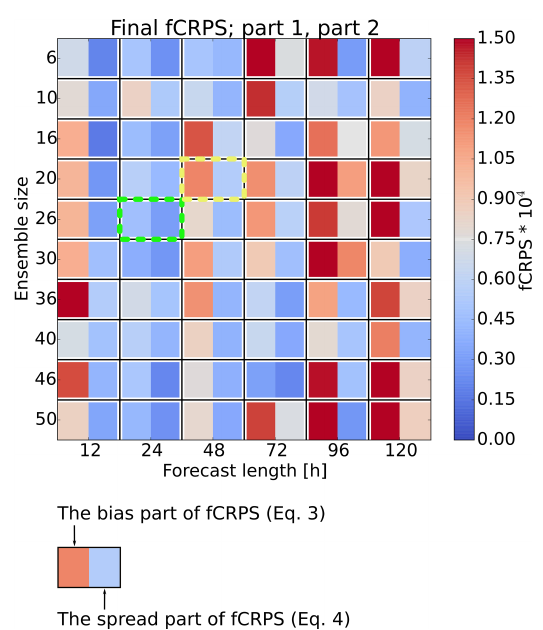
Figure 3. Components of fCRPS from the final iteration of the con- vergence tests with various forecast ranges and ensemble sizes. In this example, the optimisation algorithm is EPPES and the param- eter is θ 2 . The left-hand side of each block represents the average distance of the parameter values from the default value (Eq. 3), and the right-hand side represents the spread of the parameter value dis- tribution (Eq. 4). Low values and blue colours of both sides of the blocks indicate good convergence. Green and yellow boxes high- light the tests repeated in Fig. 5.